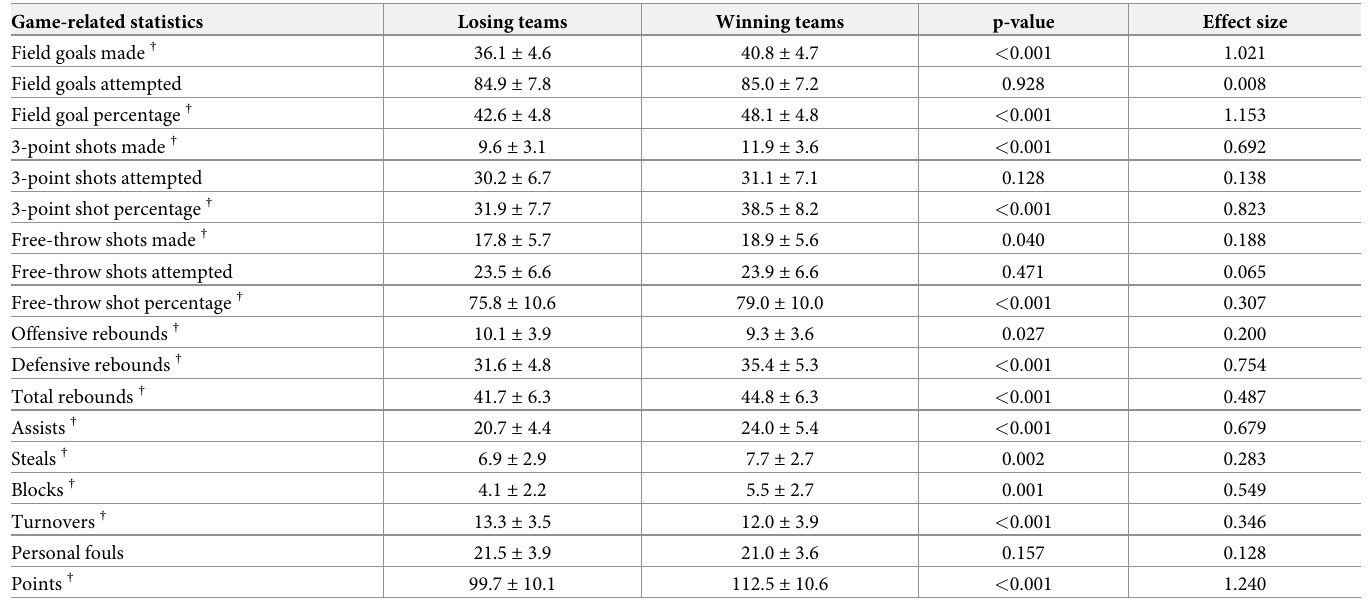
Table 3. Descriptive data ( � x � ± SD) for game-related statistical parameters between winning and losing teams during the post-season competitive period.